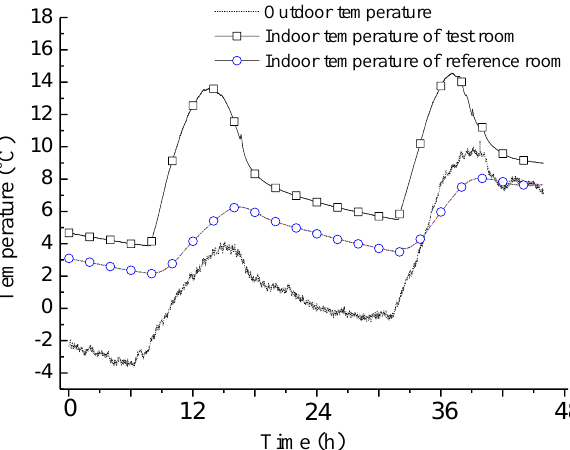
Figure 10. The average temperature of indoor air of the test and reference rooms.